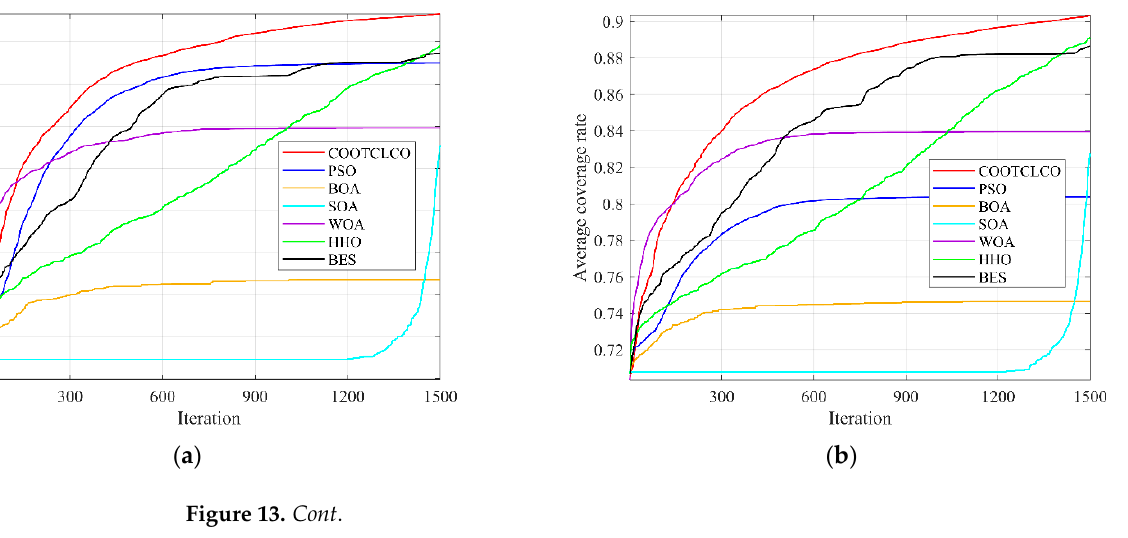
Table 10. Comparison of average coverage rate